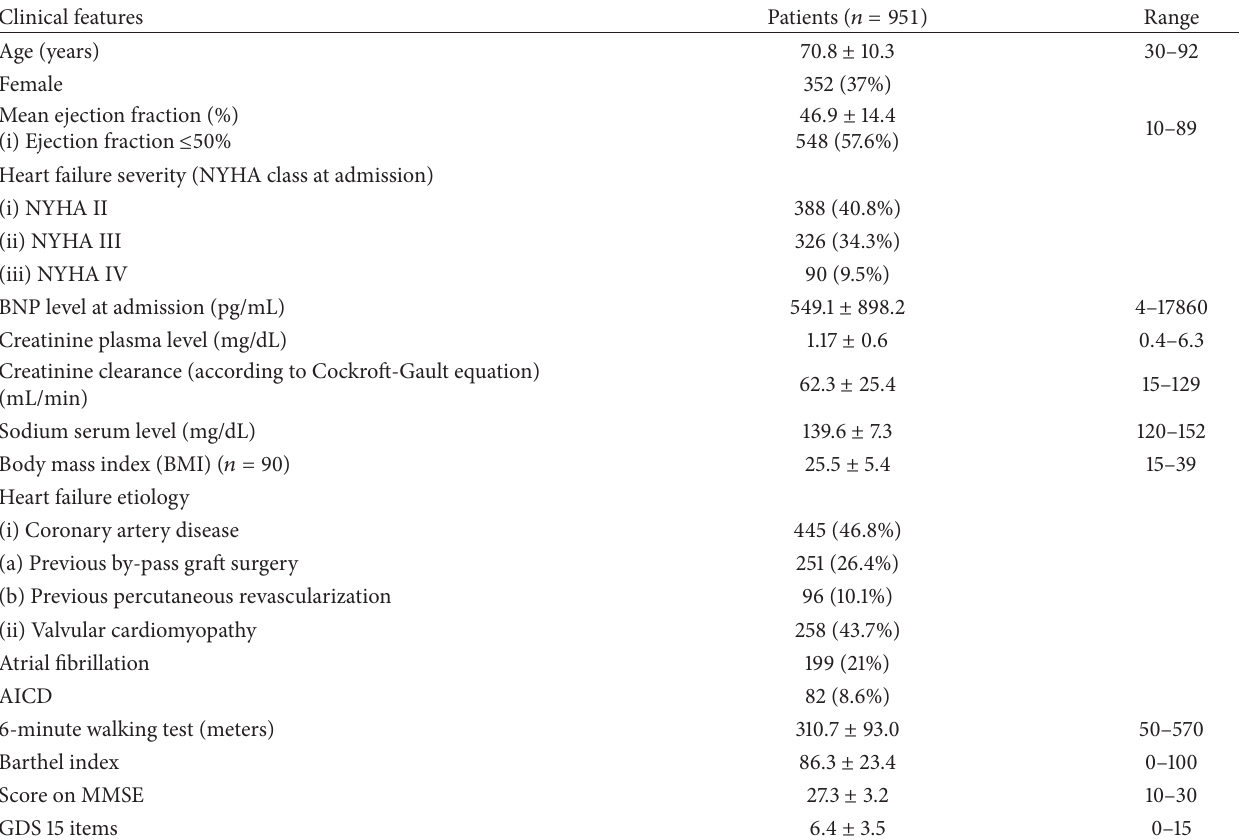
Table 1: Main demographic, clinical, and laboratory data.